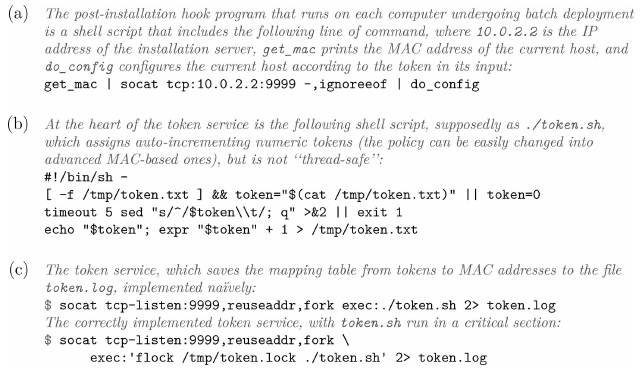
Figure 10 Implementation of a token